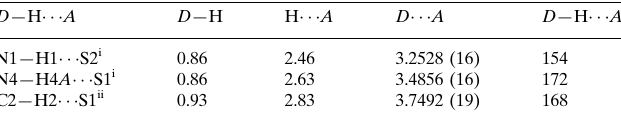
Hydrogen-bond geometry (A˚ , (cid:2)